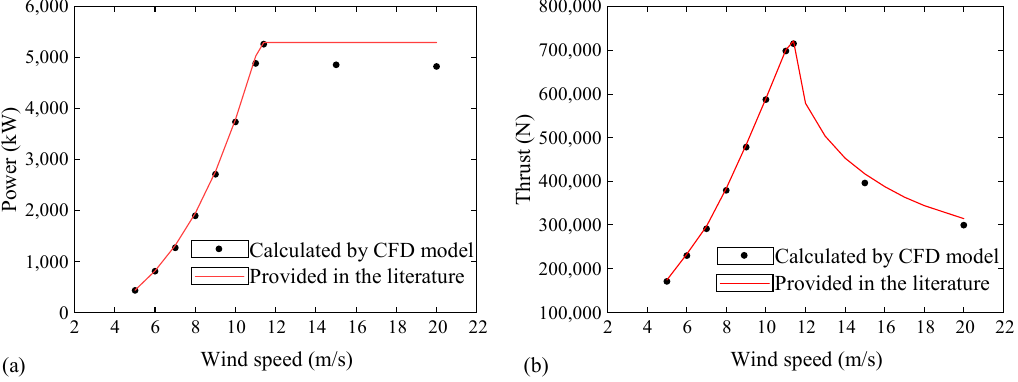
Figure 12. CFD model verification results. ( a ) Power curve; ( b ) Thrust curve.